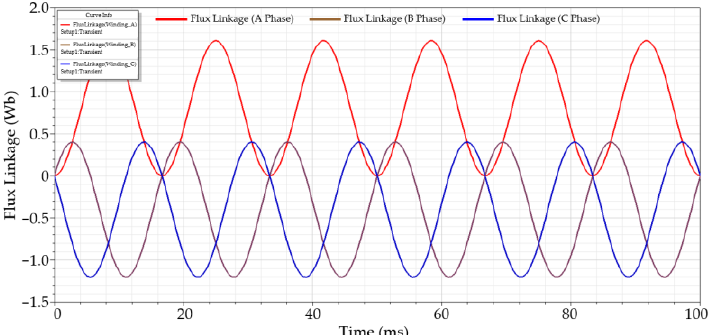
Figure 8. Simulation results of the winding flux linkage without a slow start.